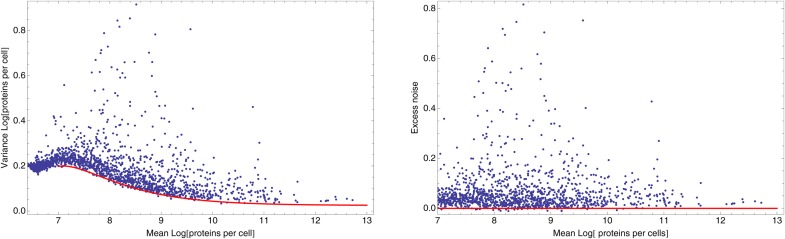
Dependence between mean and variance of log FACS intensities.Left panel: Means and variances of log-FACS intensities of all native promoters (blue dots) together with a fitted lower bound on the variance as given by Equation 67 using σab2=0.025 and β = 450 (red curve). Right panel: Excess noise (obtained by subtracting the fitted lower bound from the variance) as a function of mean log-FACS intensity for all native promoters (blue dots). The red line shows the x-axis.